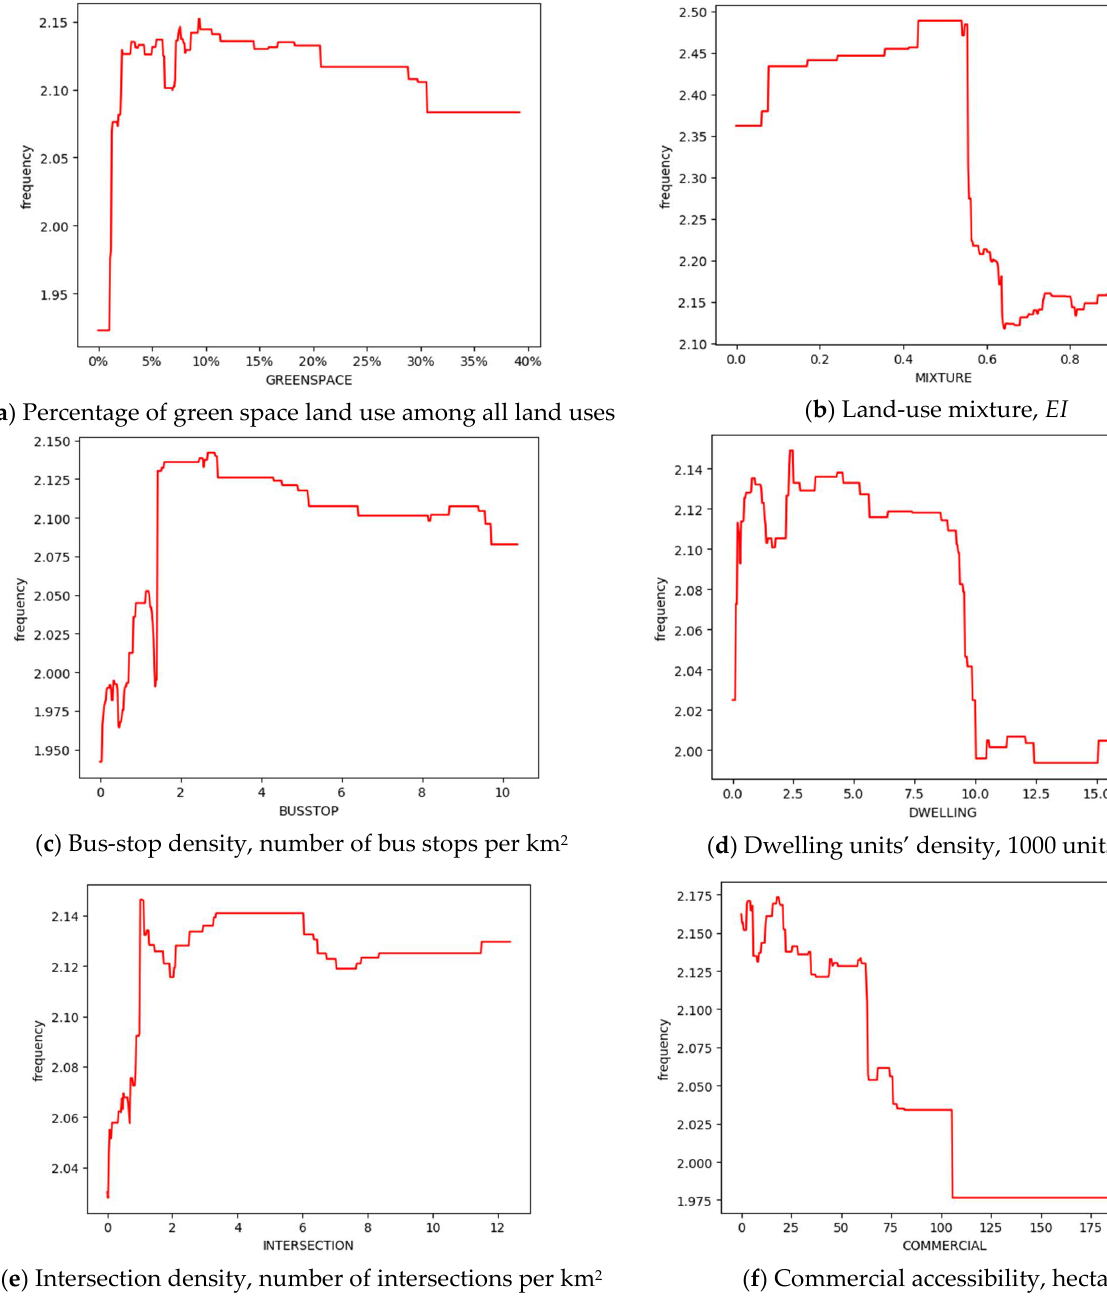
Figure 5. Associations between built environment variables and bus trip frequency among older adults in Zhongshan.